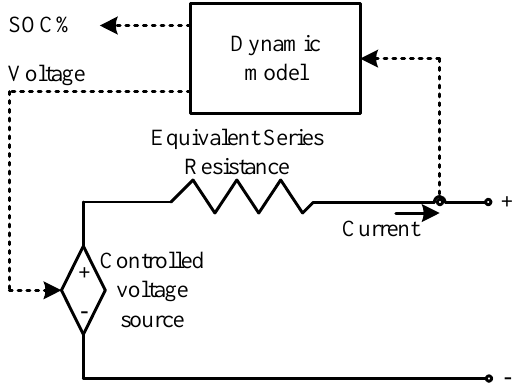
Figure 2. Equivalent circuit of EDLC simulation model in RSCAD.